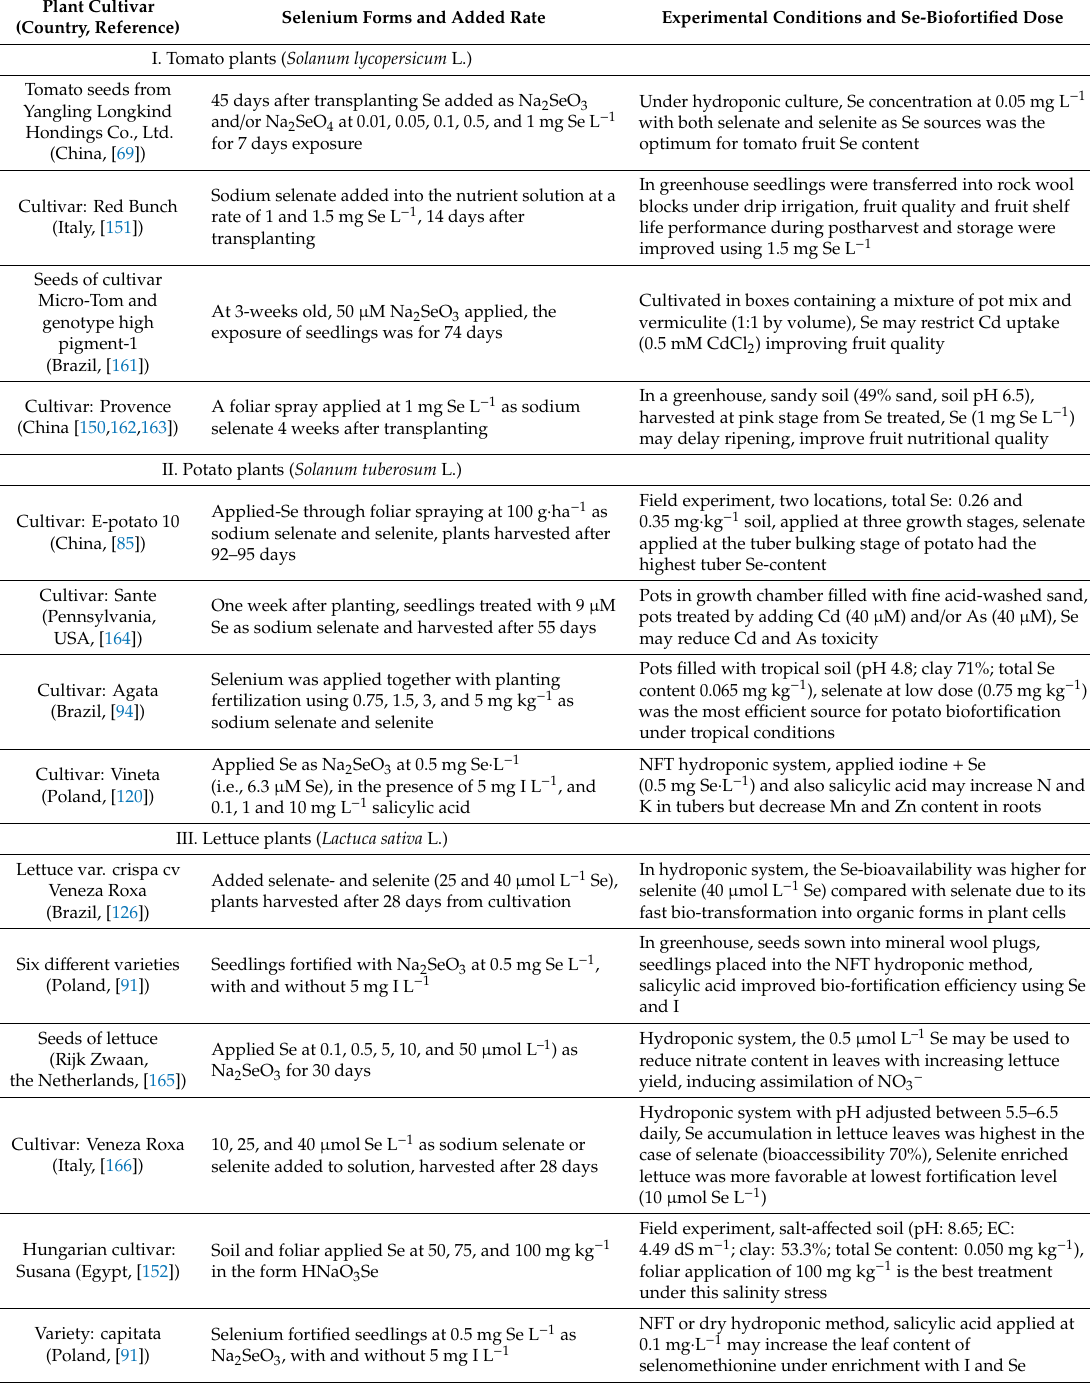
Experimental Conditions and Se-Biofortified